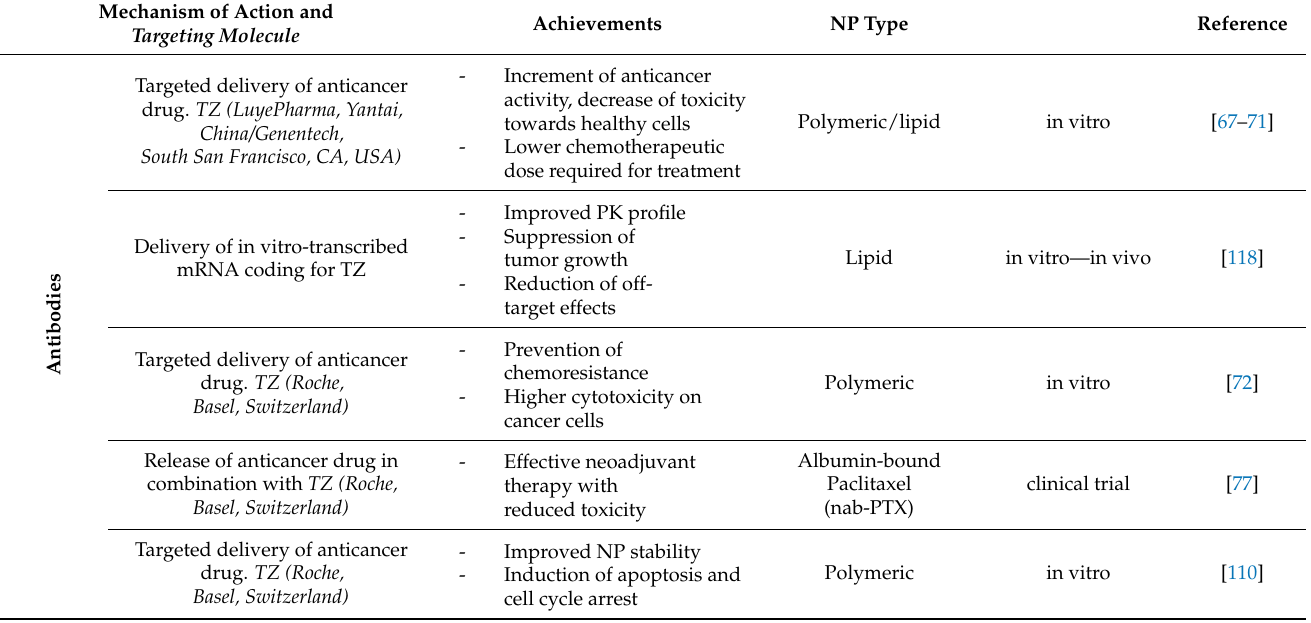
Table 1. Summary of all significant examples of organic NPs developed for HER-2 + BC